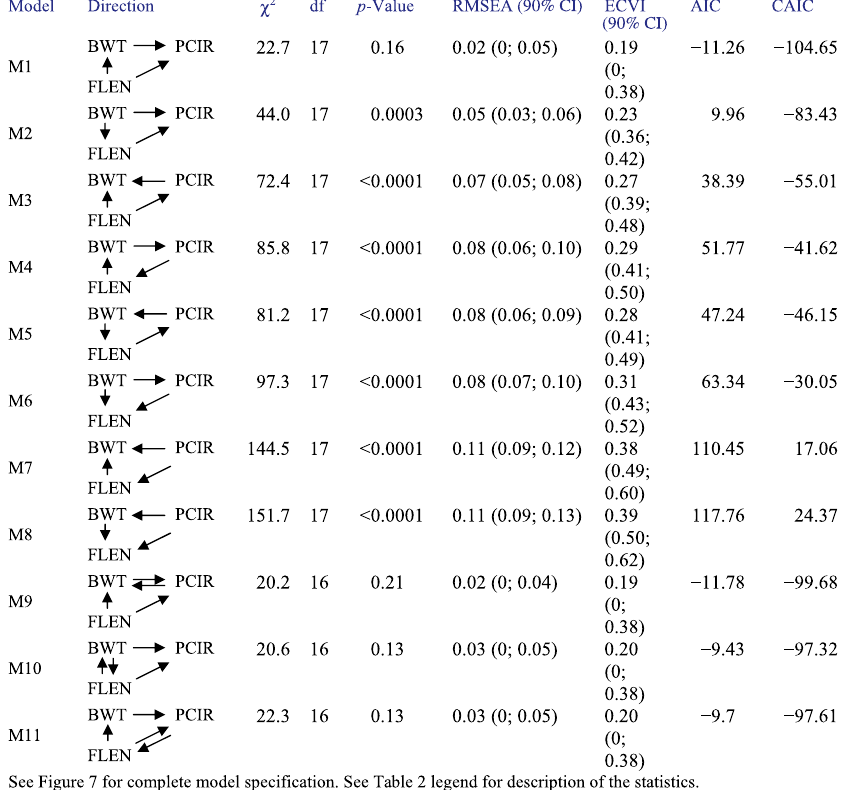
Figure 8. Model Comparison for the Bone Geometry Data Model comparisons for the bone geometry data were derived from the model in Figure 7 by varying the relationships among body weight, femur length, and periostial circumference. DOI: